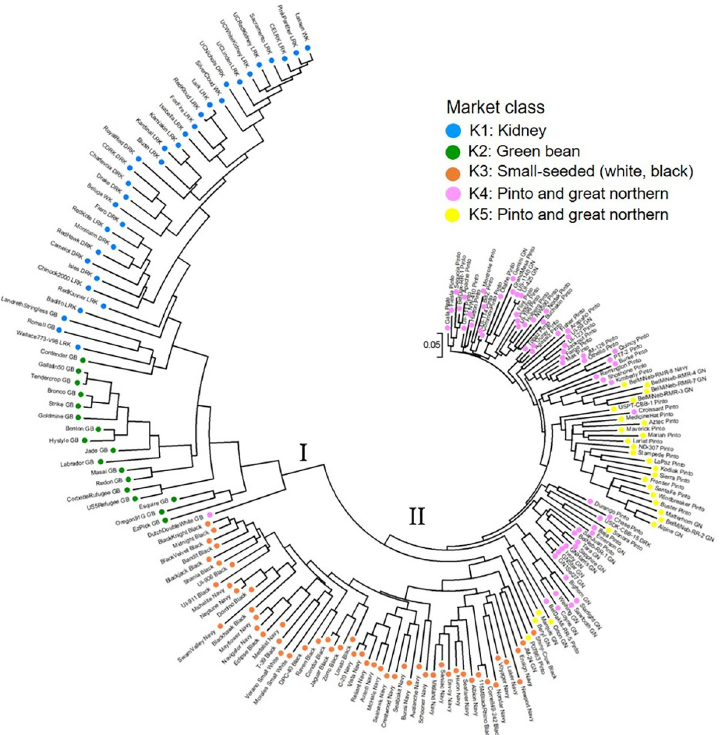
Fig 3. Neighbor-joining tree of SSRs diversity for the 192 advanced cultivars based on the C. S. Chord distance. Each branch is color-coded according to membership into the K = 5 groups identified by STRUCTURE (same colors as in Fig 2). K1 (Blue): Kidney market class; K2 (Green): Green bean market class; K3 (Orange): Small-seeded (white, black) market class; K4 (Pink): Pinto and great northern market classes; K5 (Yellow): Pinto and great northern market